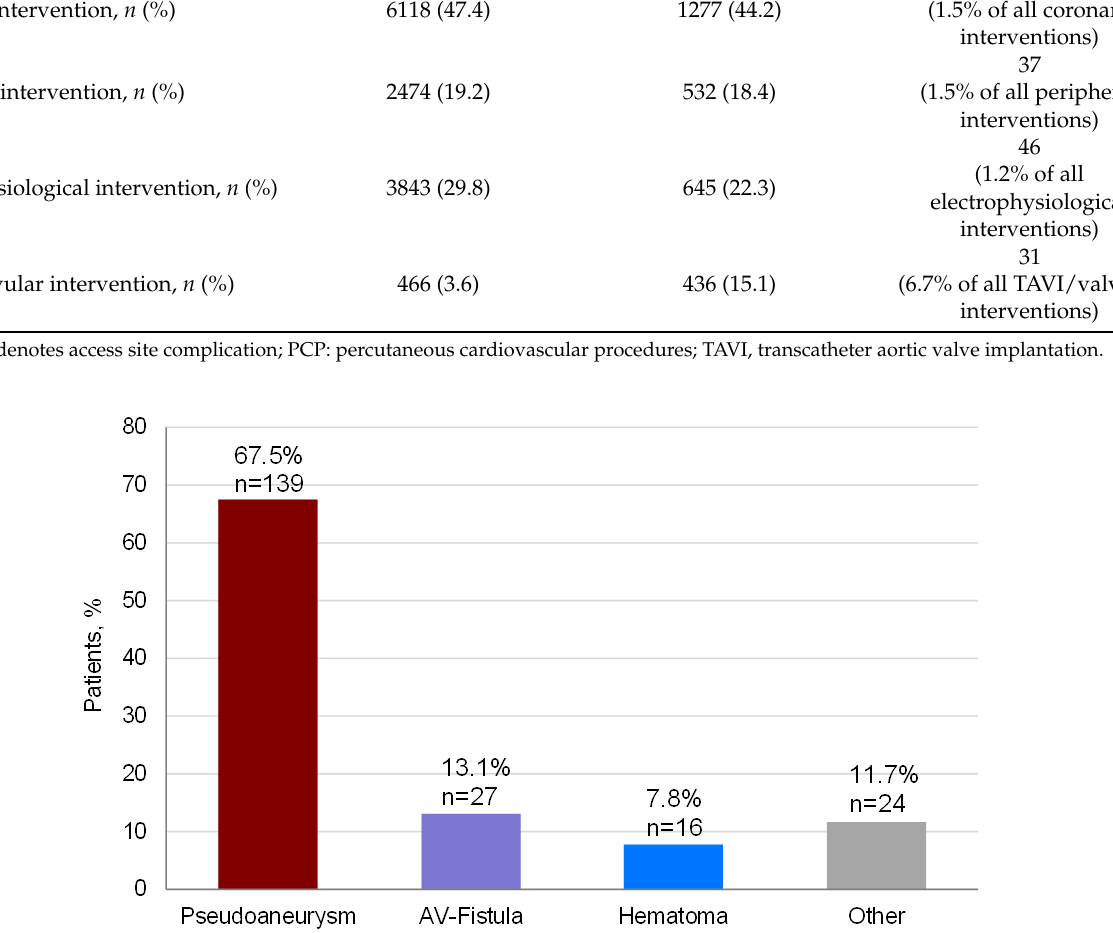
Table 1. Percutaneous cardiovascular procedures and corresponding access site complication ac- cording to procedure type.